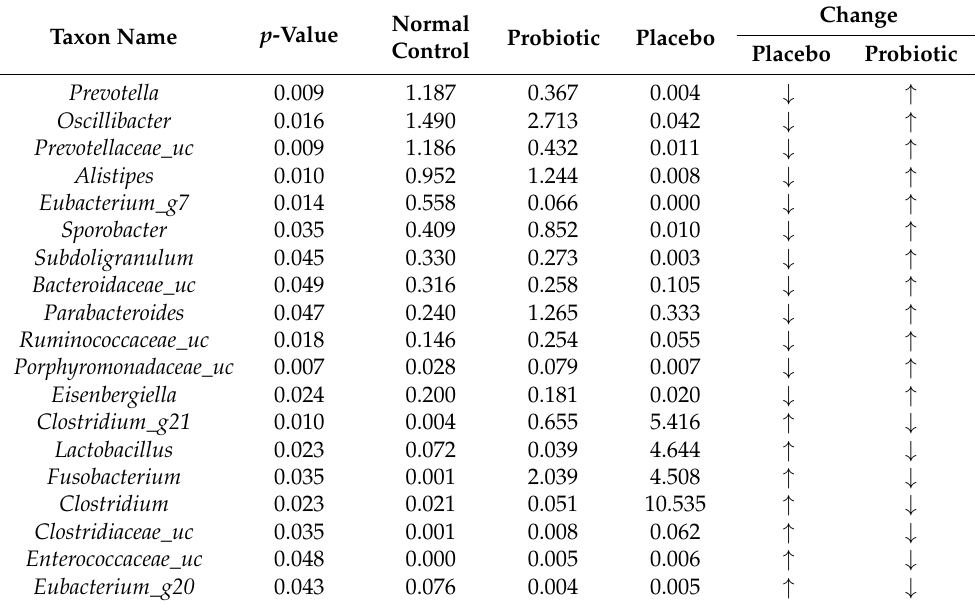
Table 4. Changes in relative abundance of genera in normal control, probiotic, and placebo groups.